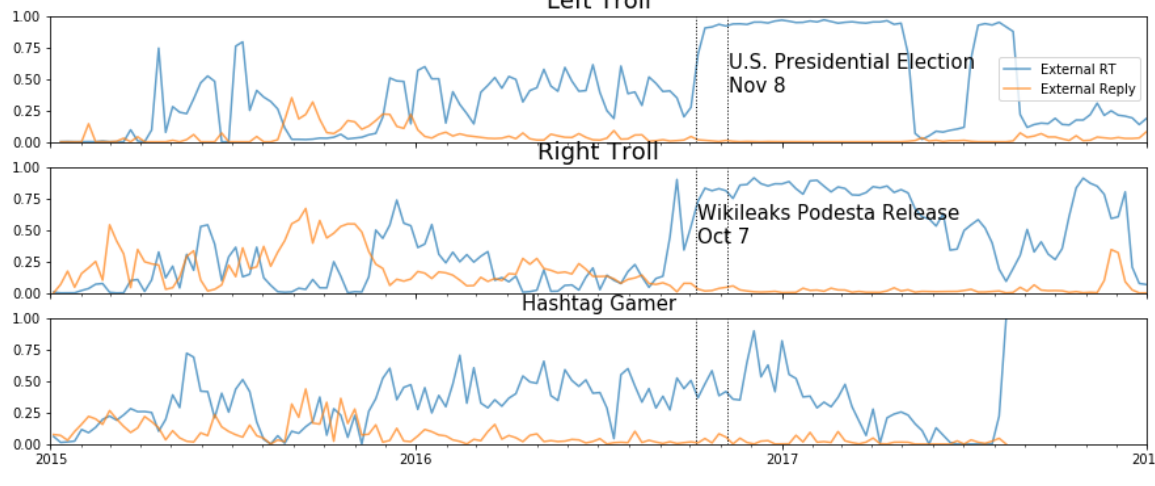
Figure 2. External Networked Output of Each Type as a Share of Overall Output by Troll Type over